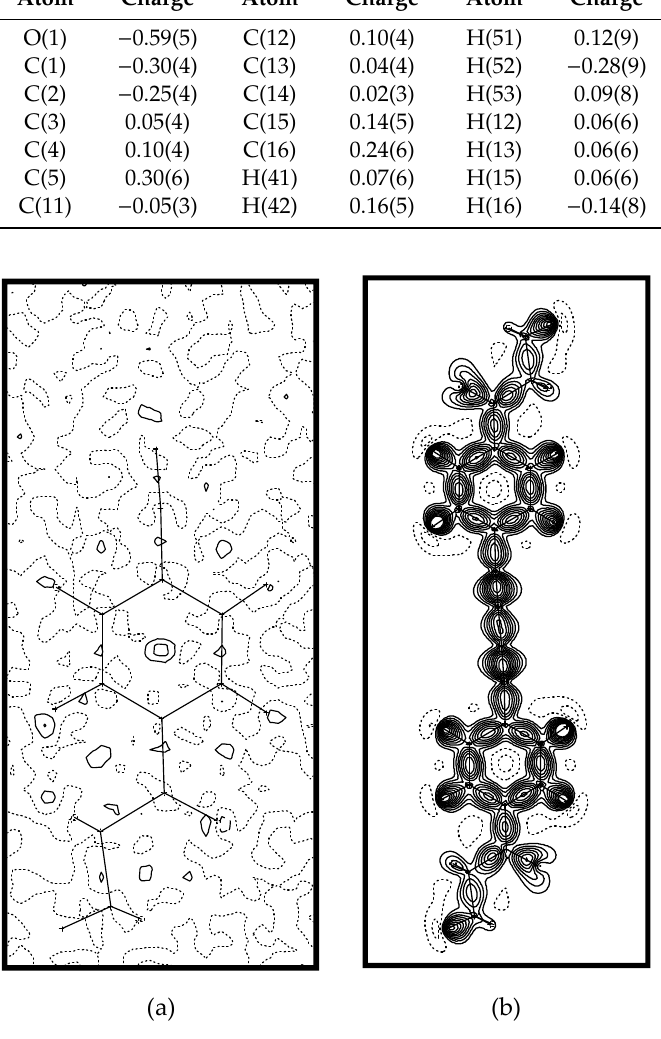
Figure 2. The final residue density ( a ) and the multipole deformation density ( b ) for 1 . Table 2. Pseudoatom charges for 1 .